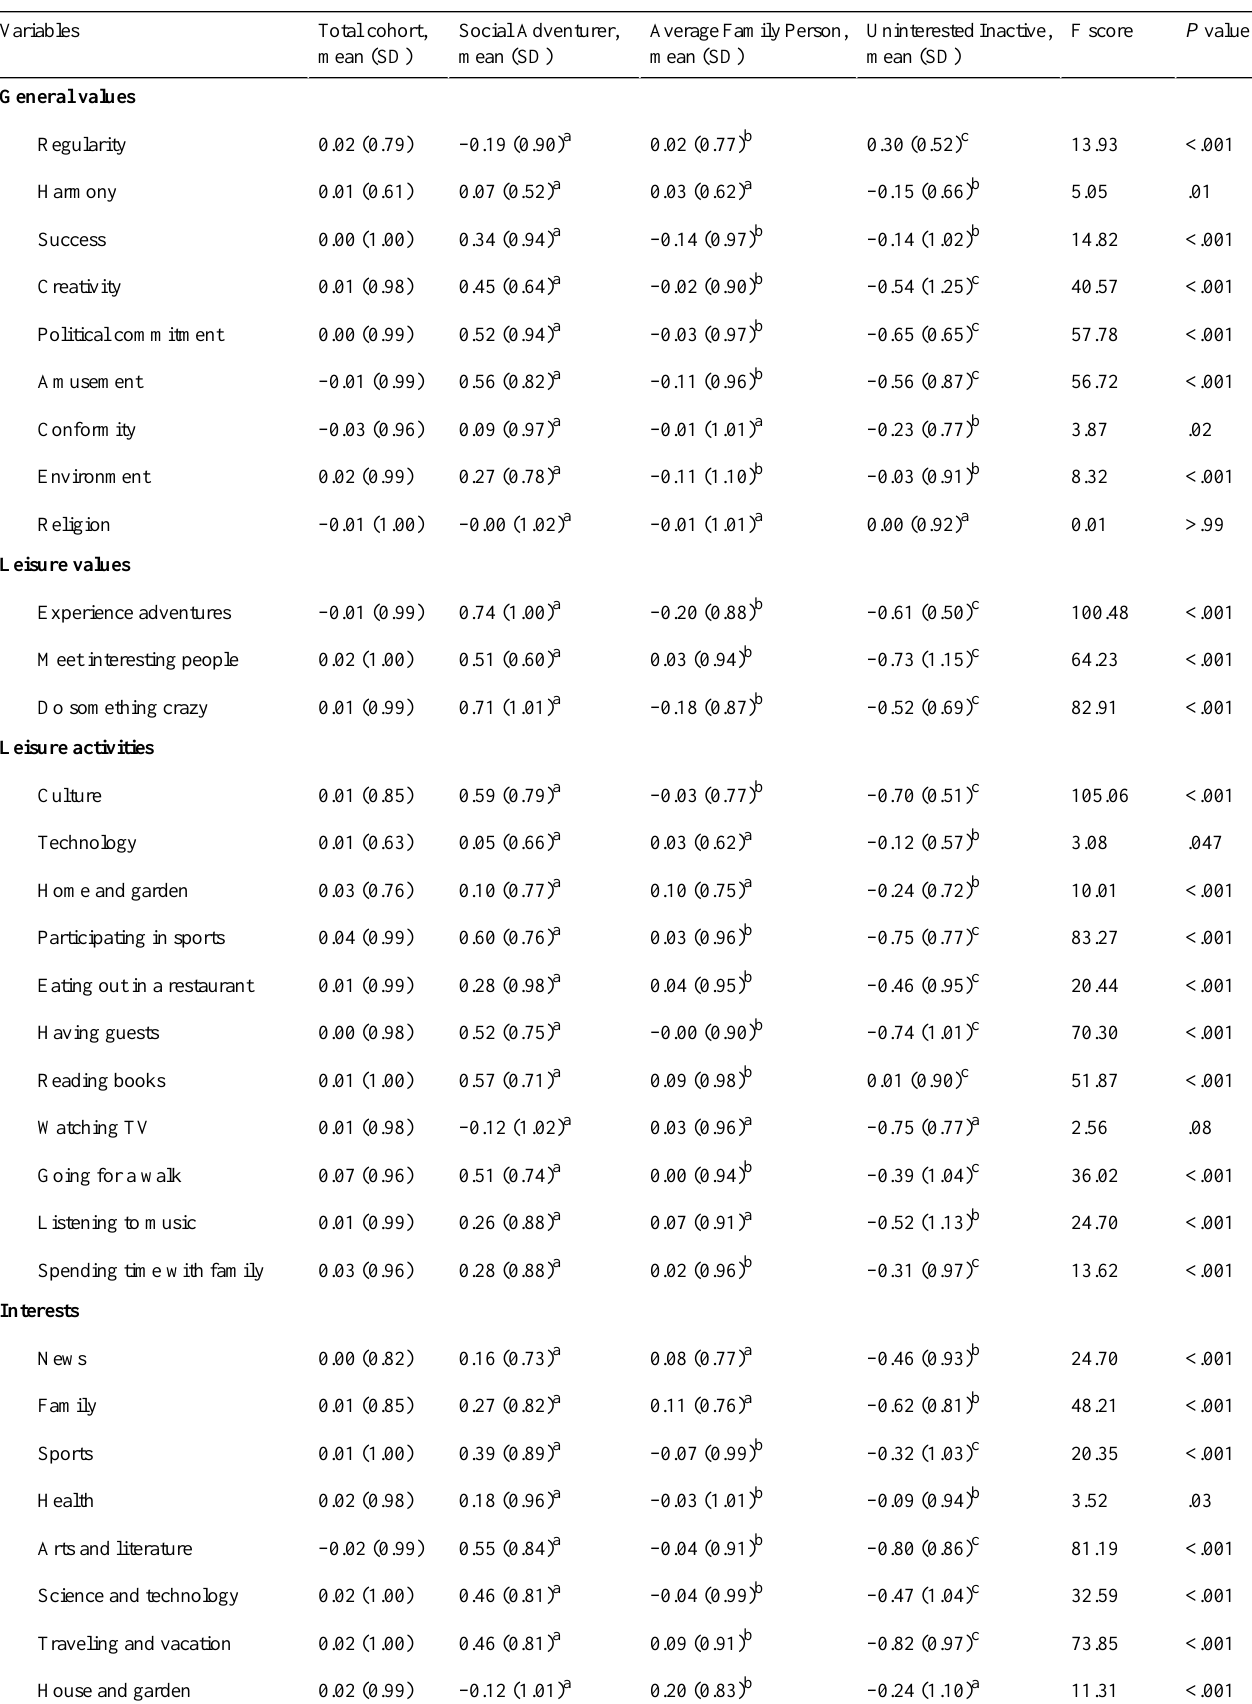
Table 2. Differences in general values and life goals, leisure values, leisure activities, and interests between the identified clusters (n=595).